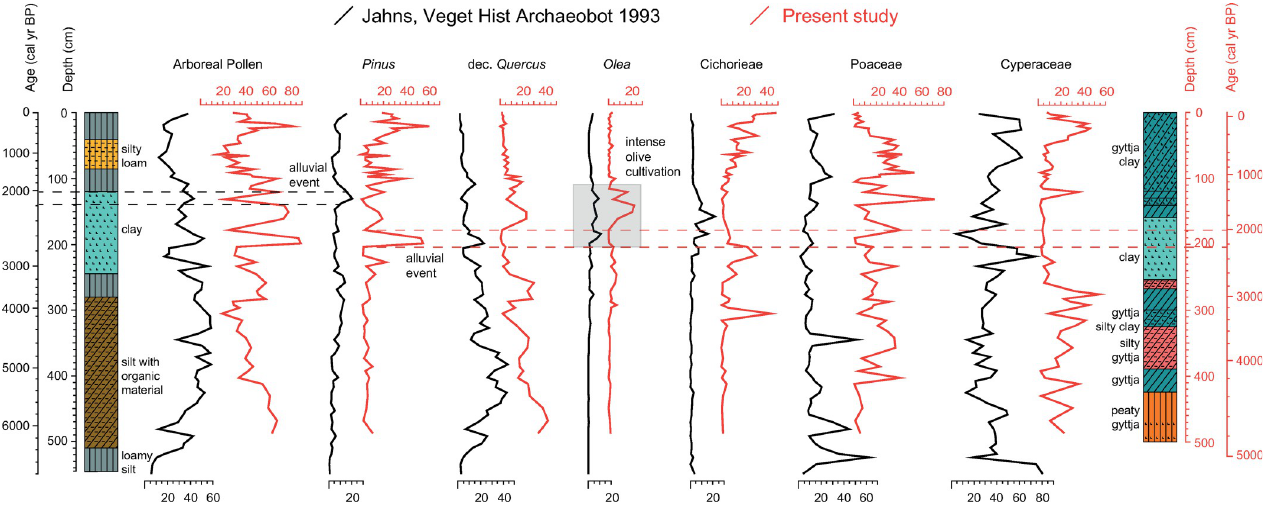
Fig 8. Comparison between pollen data of the two sediment cores available from ancient Lerna, Peloponnese (Greece). Pollen percentage diagram of selected taxa from the present study core (red) and from [13] (black), plotted against depth and aligned with sediment data. The dashed lines mark the alluvial event testified by peaks of Pinus pollen (and Abies ) in both cores. The grey square shows the portion of the sequences where differences in Olea peaks suggest a different sedimentation rate between the two cores.